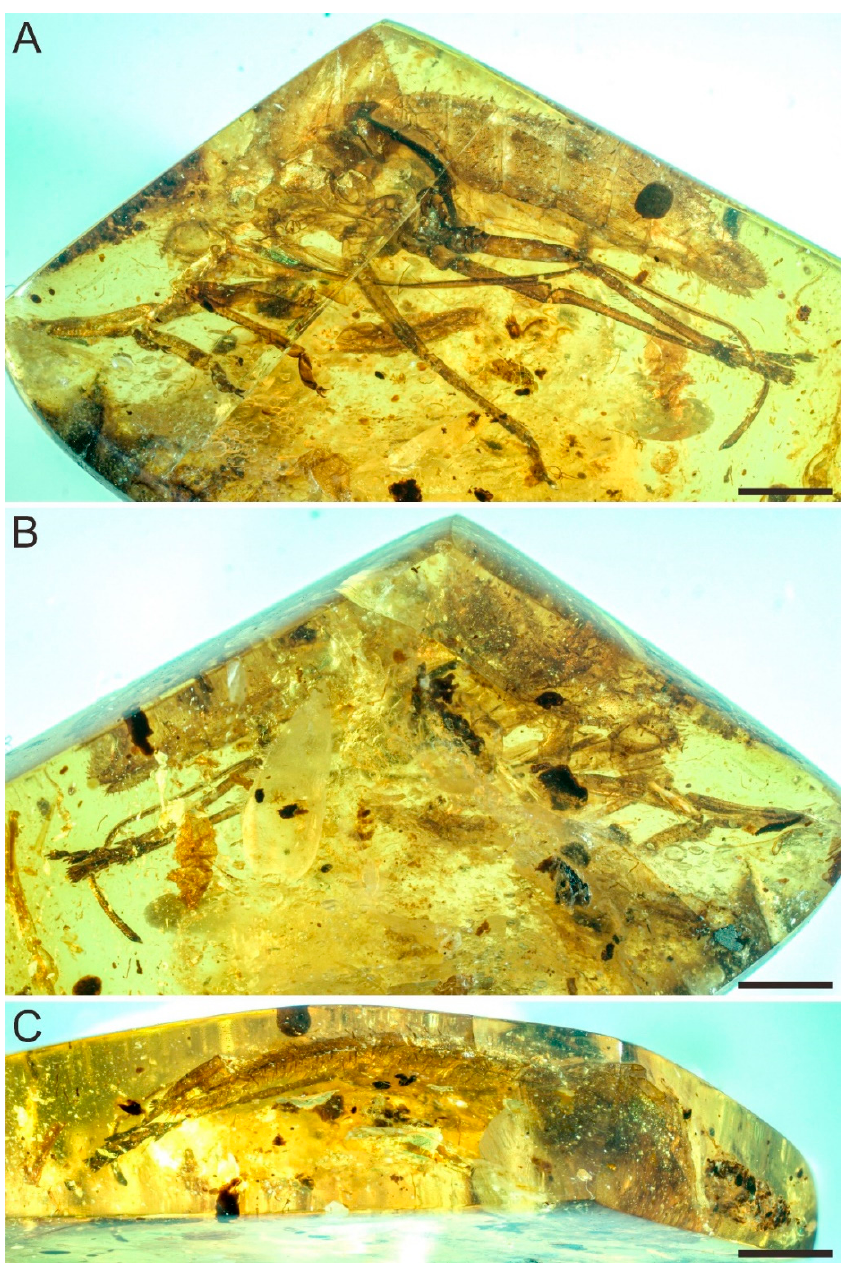
Figure 1. Holotype of Spinonympha shcherbakovi gen. et sp. nov. (NIGP174758). ( A ) Left lateral view. ( B ) Right lateral view. ( C ) Dorsal view. Scale bars = 2 mm.